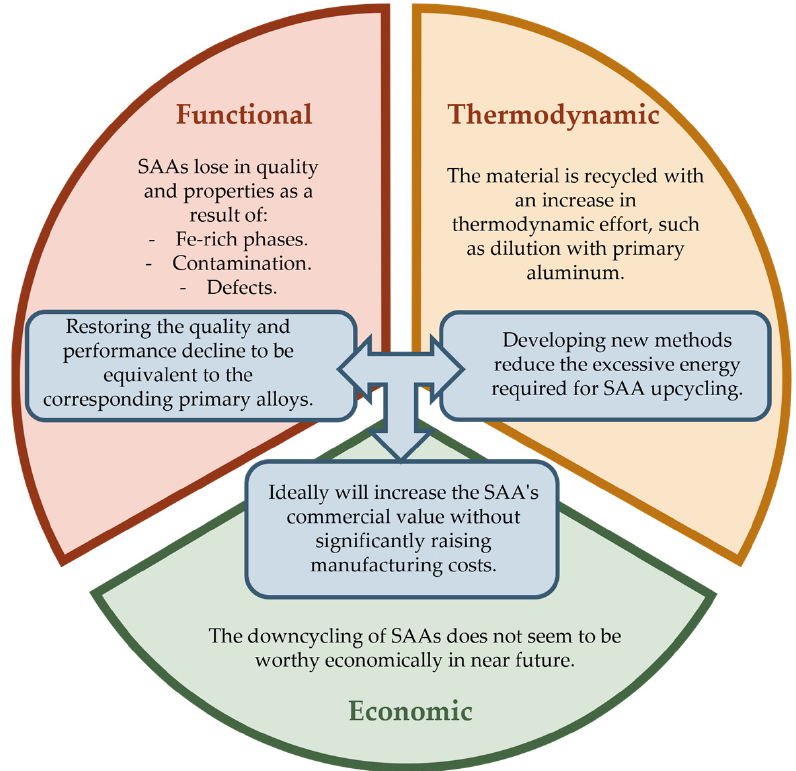
Figure 4. The prospective of the Al downcycling approach.